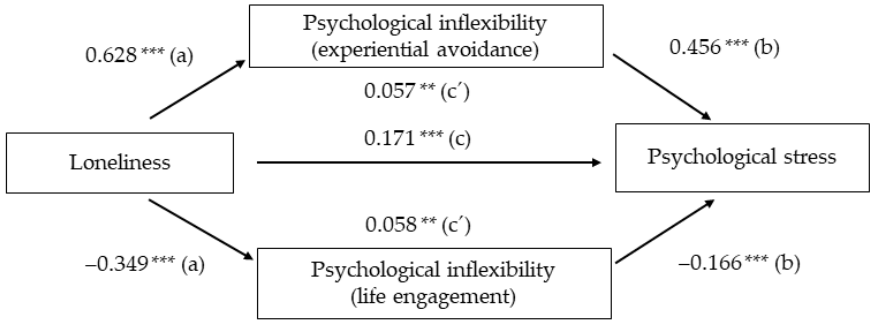
Figure 1. Mediation effect of psychological (in)flexibility on the relationship between loneliness and psychological stress. “a”, “b” and “c” represents pathways for direct effects; “c´” represent pathways Figure 0. *** p < 0.001.